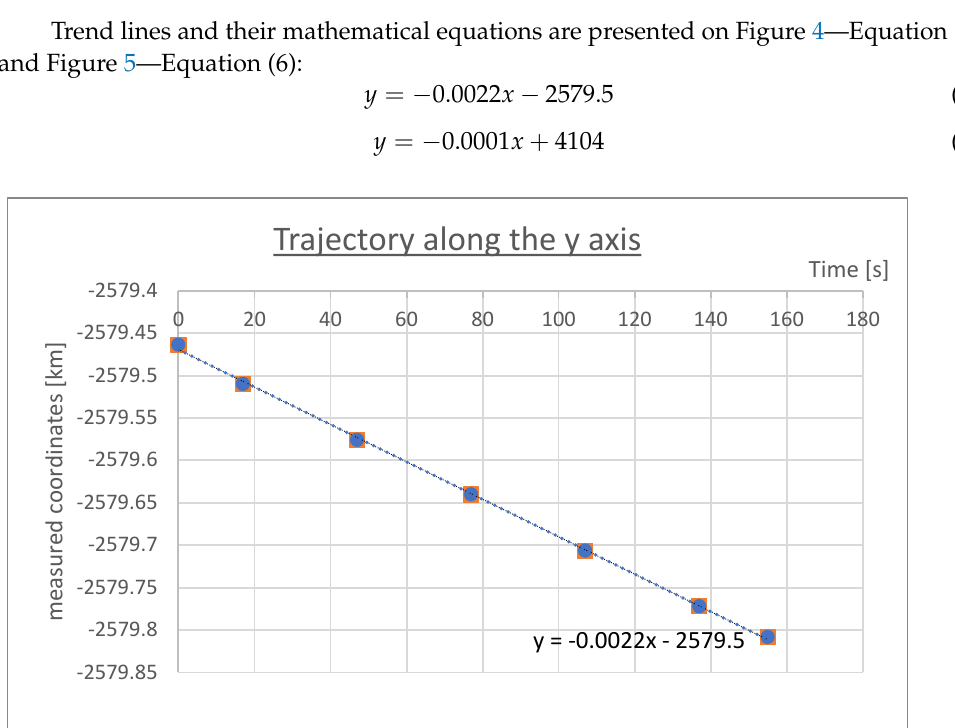
Figure 4. Geographical coordinates conversion, y